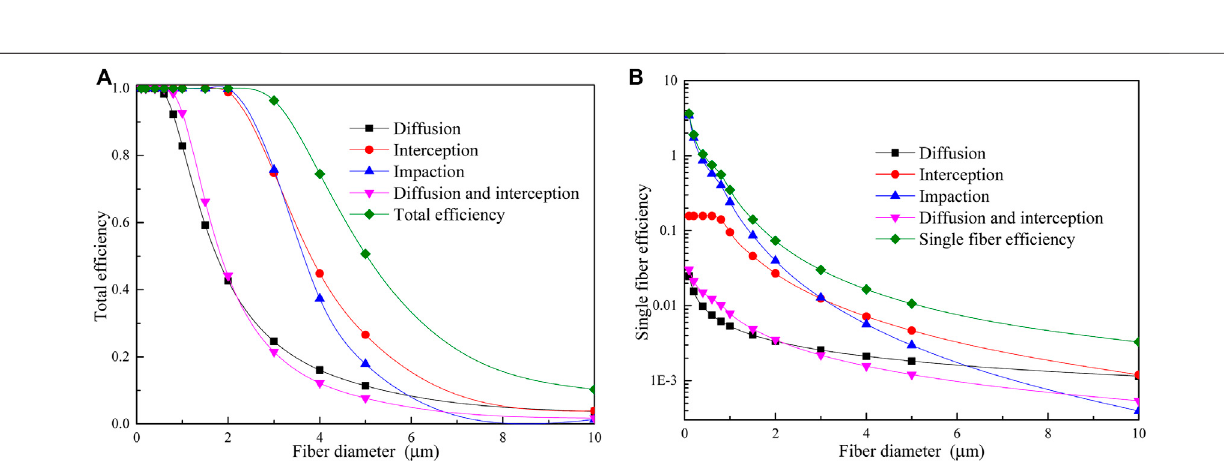
Frontiers in Energy Research |